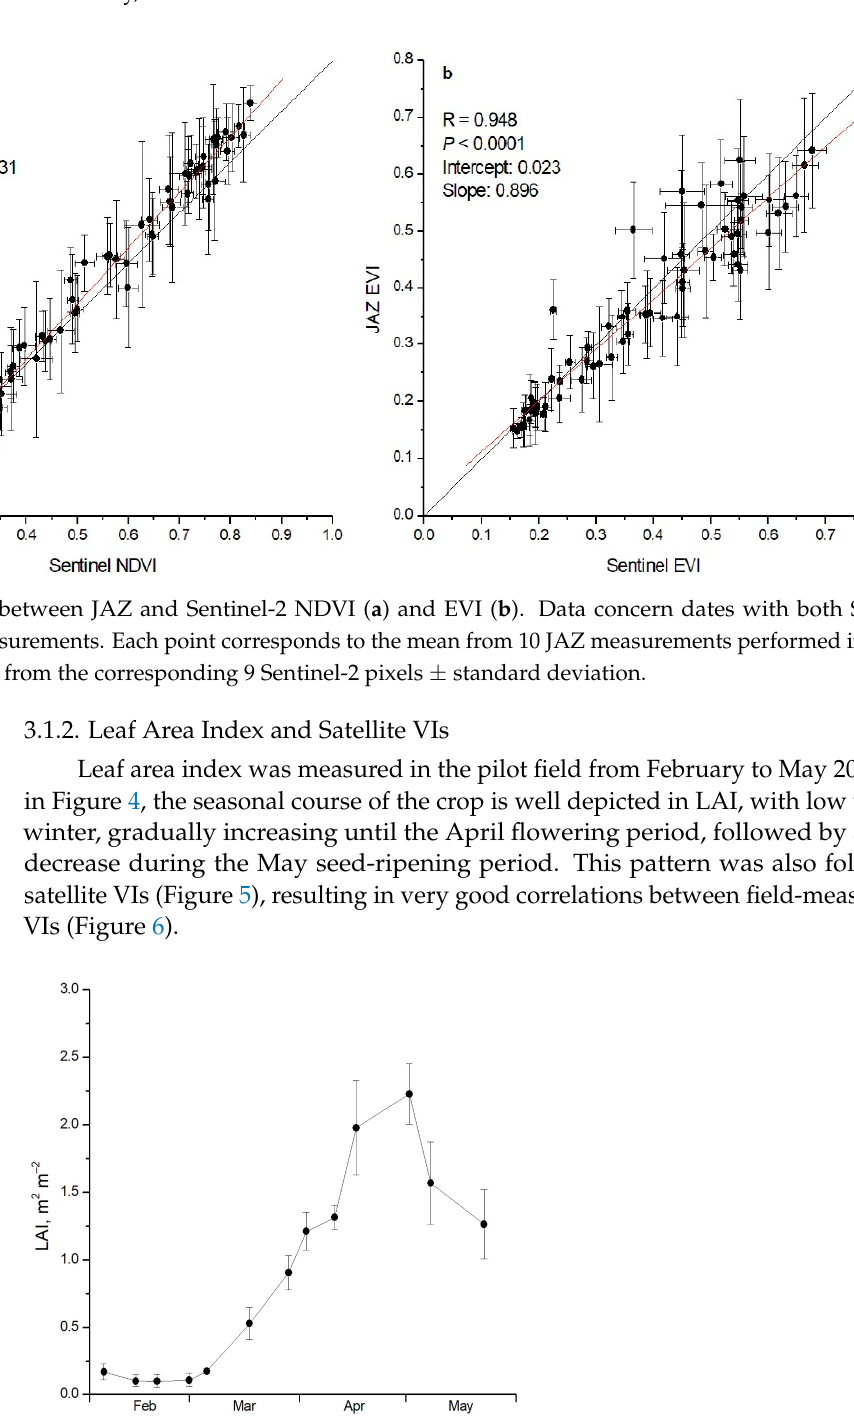
Figure 4. Seasonal fluctuation of leaf area index. Data are means from six plots (10 measurements per plot) ± standard deviation.